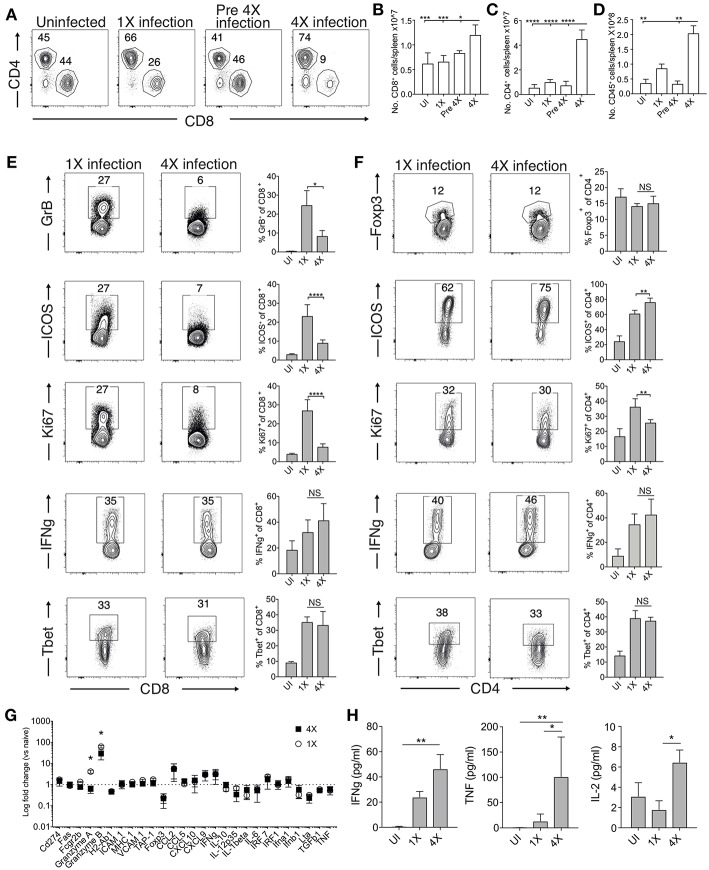
4X infected mice develop significantly altered splenic CD8+ and CD4+ T cell responses. (A–H) Spleens and plasma were removed from 4X infected and age-matched 1X infected C57BL/6 mice on day 8 post-infection (when 1X infected mice developed ECM), from pre-4X infected C57BL/6 mice (minimum 30 days post clearance of 3X infection), and age-matched uninfected mice. (A) Representative flow cytometric plots and the frequencies of splenic CD8+ T cells and CD4+ T cells, gated on live CD45+ CD3+ cells. Total numbers of splenic (B) CD8+ T cells, (C) CD4+ T cells and (D) CD45+ cells. (E,F) Representative flow cytometric plots and the frequencies of splenic (E) CD8+ T cells and (F) CD4+ T cells expressing markers of activation, function and differentiation. (G) Nanostring analysis of gene expression in whole spleen tissue from 4X and 1X infected mice (on day 8 of infection), expressed relative to gene expression in age-matched uninfected mice (fold change of 1 defines level of gene expression in uninfected mice). (H) Cytokine bead array of plasma cytokine levels in 4X, 1X infected mice and aged matched uninfected C57BL/6 mice. (A,E,F) Numbers denote the percentage of cells within the gate. (B–G) Results are the mean ± SD of the group, representative of two independent experiments with (B–D)
n = 3–6 per group, (E,F)
n = 3–10 per group and (G)
n = 3 per group. (H)
N = 4–7 per group, pooled from two independent experiments. (B–F,H) Statistical analyses were performed with Kruskal-Wallis test with Dunn's multiple comparisons test or with one-way ANOVA with Tukey's test, depending on normality of data (*p ≤ 0.05, **p ≤ 0.01, ***p ≤ 0.001, ****p ≤ 0.0001). (G) Statistical analysis by Student's t-test, with Welch's correction (*p ≤ 0.05).